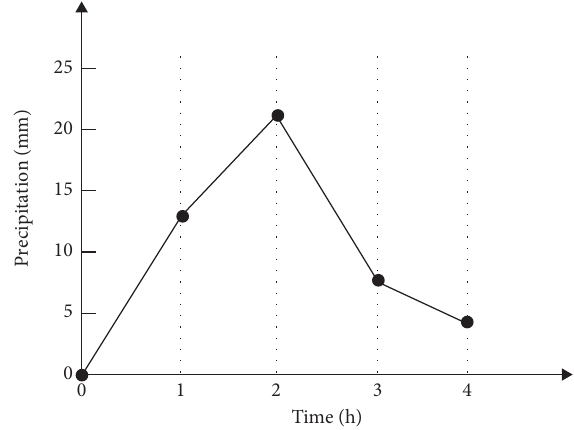
Figure 2: Diagram of rainstorm process